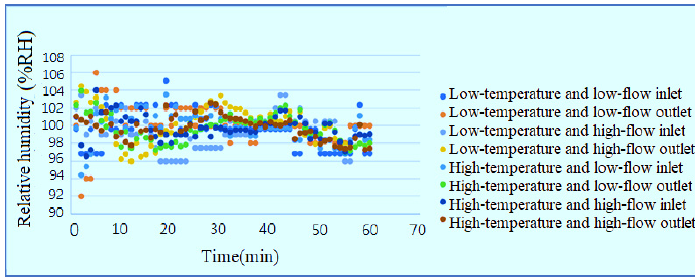
Figure 18. Outlet/inlet humidity curve diagram.